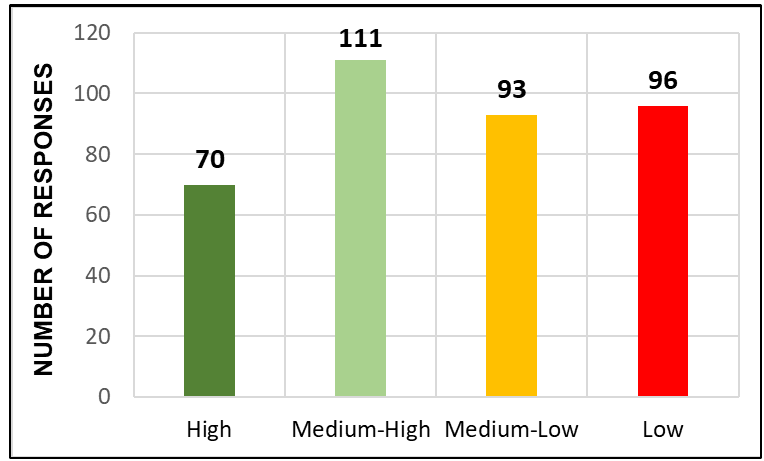
Figure 5. Energy- Use Behavior of Hotel Guests’ Opportunity Level . Figure 5. Energy-Use Behavior of Hotel Guests’ Opportunity Level.